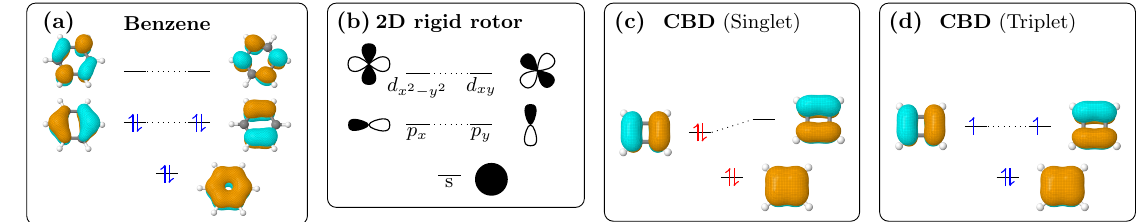
Figure 3. The concept of aromaticity illustrated using the 2D rigid rotor whose eigenstates are shown in ( b ). Benzene ( a ) and cyclobutadiene ( c , d ) are shown, highlighting the similarity between the π -MOs in these systems and the idealised rigid rotor eigenstates. With singlet multiplicity filled levels are obtained with 4 n + 2 electrons ( a ) whereas with 4 n electrons ( c ) the HOMO and LUMO are quasidegenerate deriving from the same rigid rotor level. The rules are reversed for the triplet, which obtains filled shells with 4 n electrons ( d